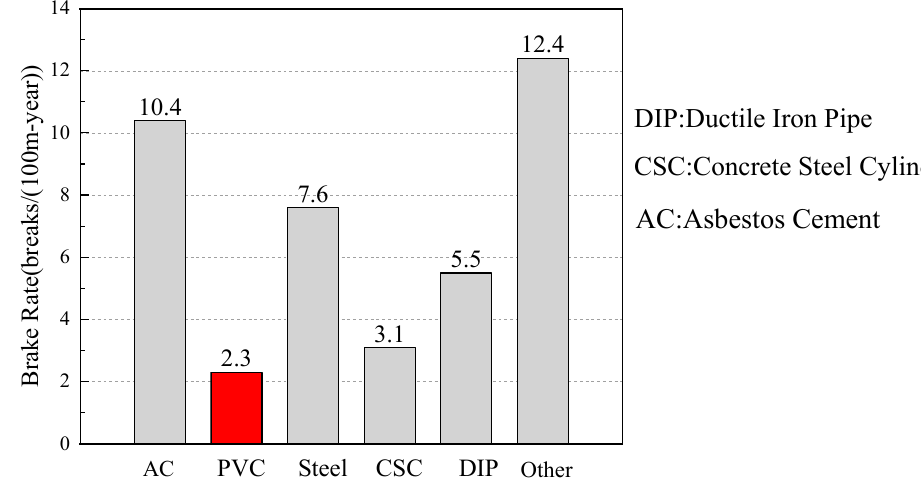
Figure 1. The proportion of broken water pipes and failures [2].